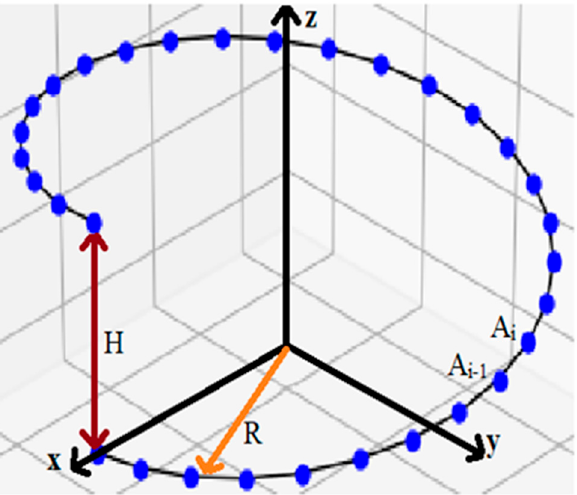
Figure 2. Normalization of chirality. The blue dots are reference points for this